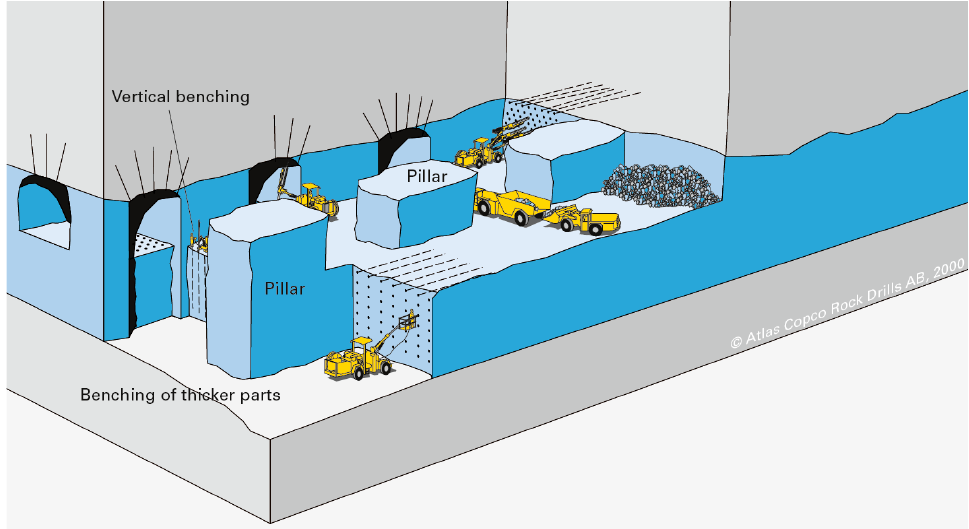
Figure 3. Example of a typical room and pillar layout [11]. Reprinted/adapted with permission from Ref. [11]. 2023, Epiroc Deutschland GmbH.